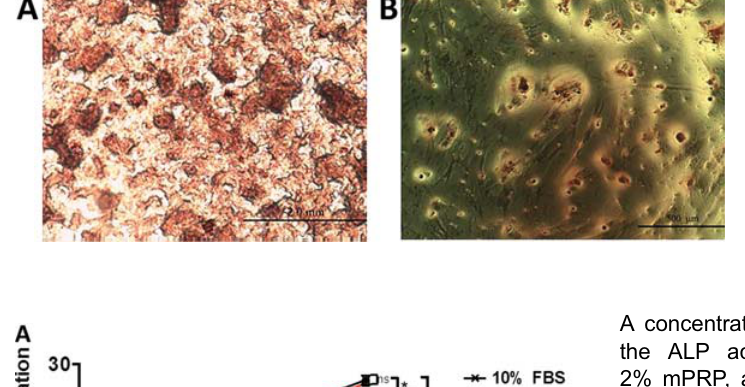
Figure 2. Stem cells from human exfoliated decid- uous teeth presented a high differentiation capacity during adipogenesis and mineralization. A , cells after 30 days treatment with mineralization induction medium. Cells were stained with Alizarin red, (cid:1) 10. B , cells after 21 days treatment with adipogenesis induction medium. Cells were stained with oil red-O, (cid:1) 100.